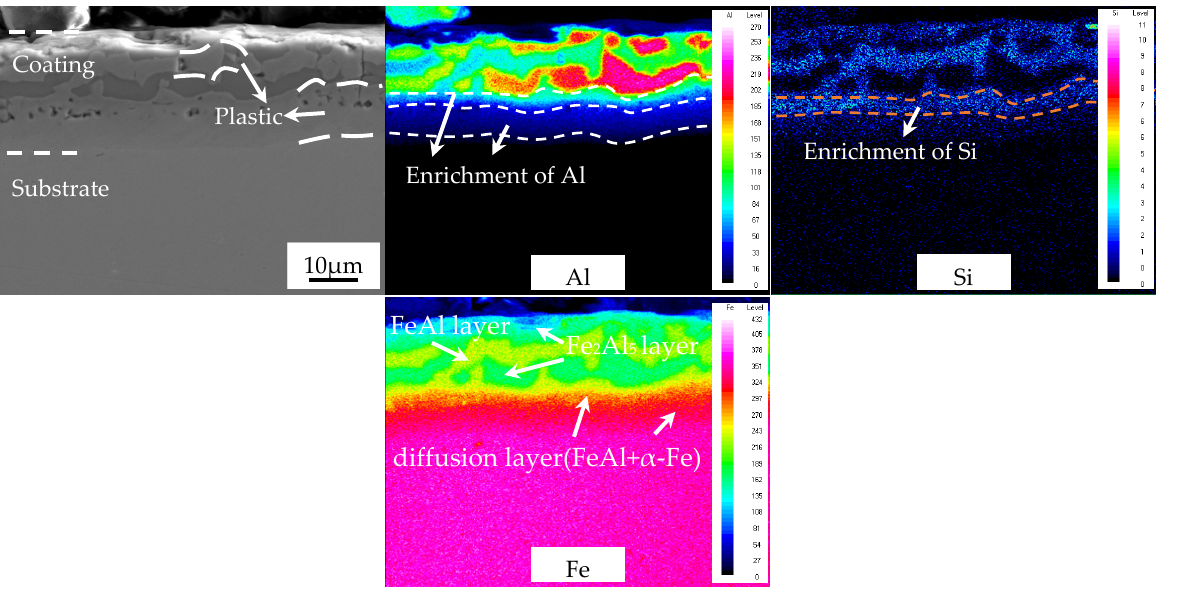
Figure 15. EDS map scan result of interface between the AS60/60 coating and the steel substrate at 50% reduction ratio at TAUS = 930 °C for 5 min.